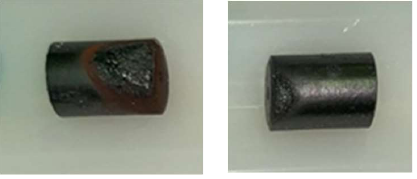
Figure 3. Fuel pellets obtained by microwave sintering in the vertical position.